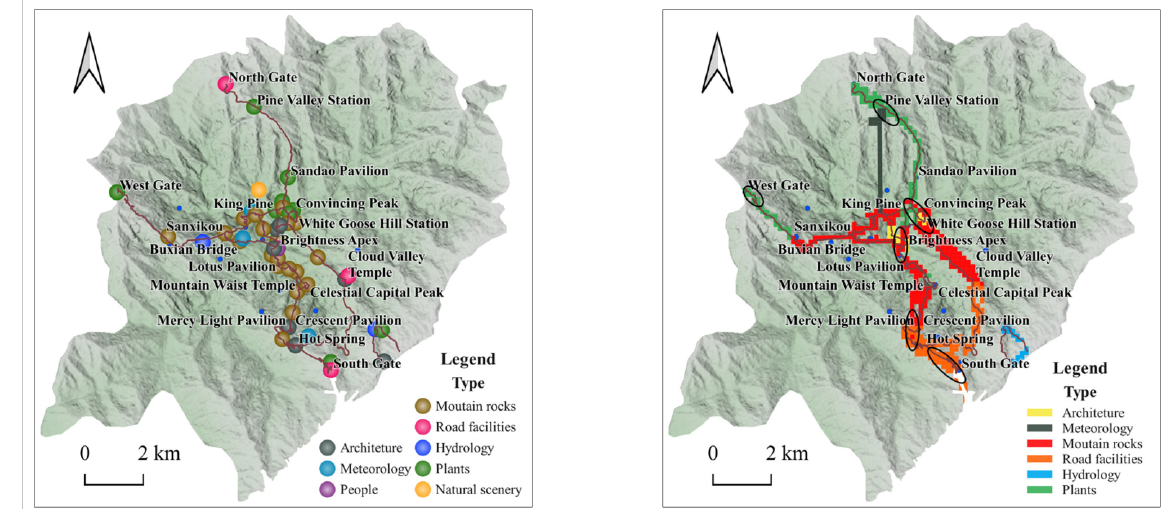
Figure 6. Tourists’ photos focus in terms of scenic spots and